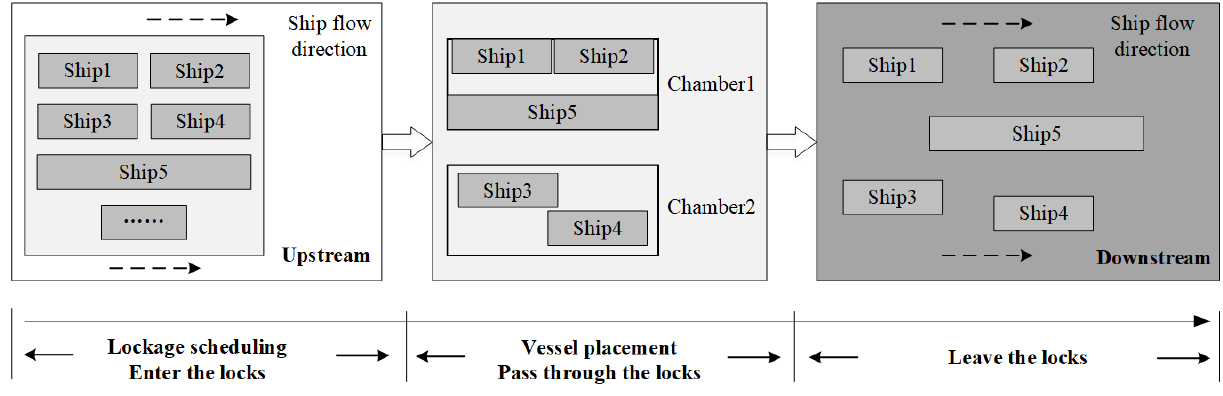
Figure 3. Lock scheduling problem.